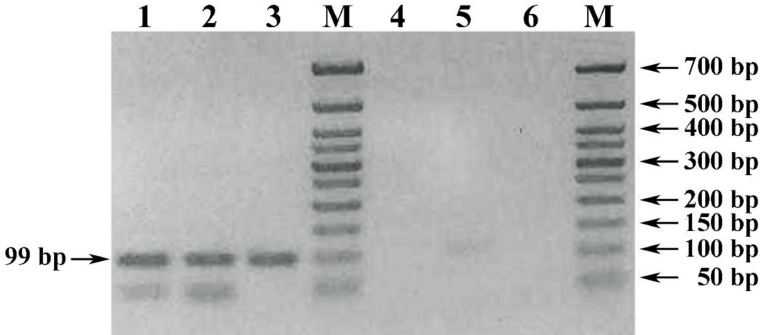
Figure 5. Electrophoregram of results of PCR amplification of the Vitis vinifera L. UFGT gene locus with UFGT-F1 and UFGT-R1 primers. Legend: (1–3) PCR of a DNA sample extracted by lysis with DMSO of the precipitated debris of young Cabernet Sauvignon wine, prepared by a 10 min exposure of the wine material mixed with PVP and isopropanol. (4–6) PCR of a DNA sample extracted by lysis with DMSO of the precipitated debris of young Cabernet Sauvignon wine, sampled by a 10 min exposure of the wine material mixed with PVP. M) DNA size markers 50+ bp (Evrogen JSC, Moscow, Russia).